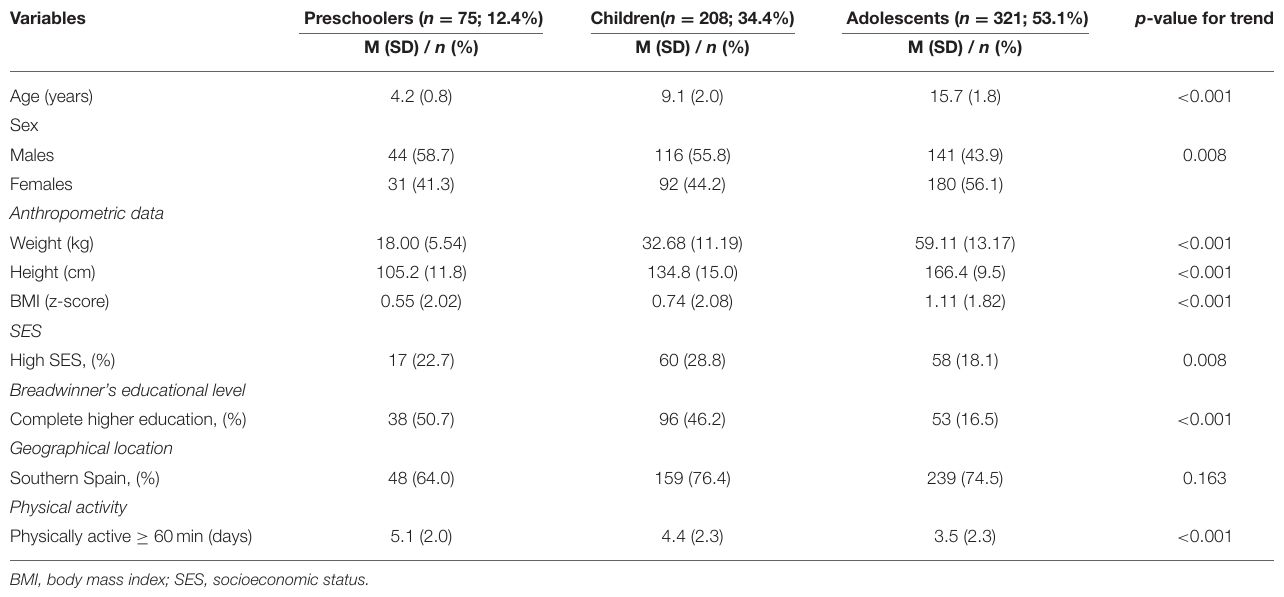
TABLE 1 | Descriptive information of the Spanish analyzed sample ( n = 604).